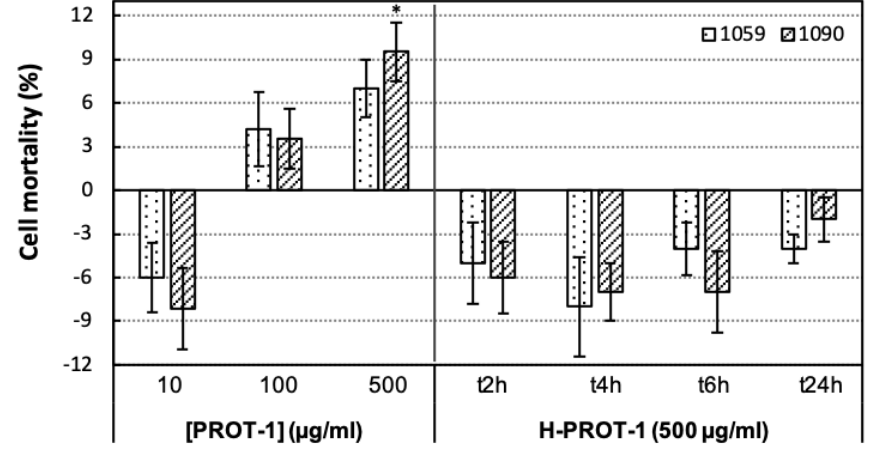
Figure 6. Effect of PROT-1 and H-PROT-1 on fibroblast mortality in vitro (LDH assay). Results are expressed as the mean relative percentage of living fibroblasts compared to the negative control (0%). Significant differences between values obtained with samples and negative control ( n = 8) are indicated by * ( p < 0.05).